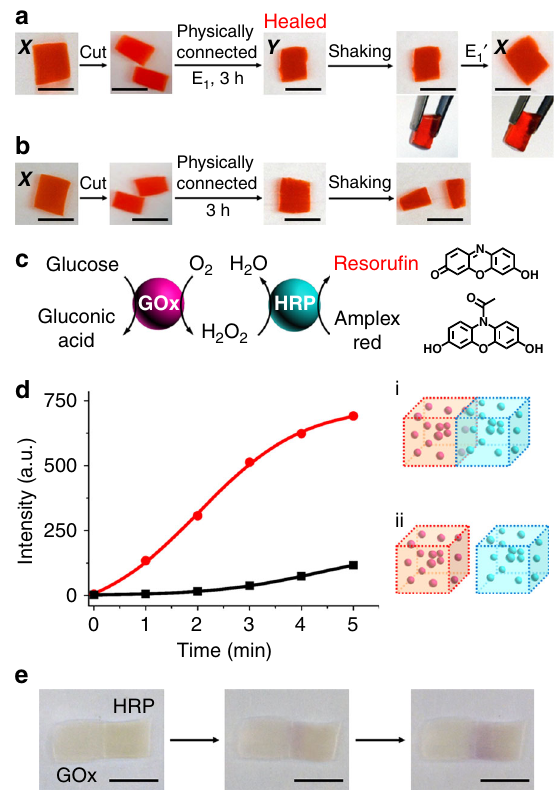
Fig. 4 Self-healing of the CDN hydrogel matrices for a biocatalytic cascade. a Self-healing of CDN hydrogel X. The hydrogel was cut into two pieces which were physically interconnected. The E 1 -induced transition of hydrogel X to the stiffer CDN hydrogel Y, yielded the healed hydrogel Y. Treatment of the healed hydrogel Y with E 1 ’ regenerated the healed hydrogel X. b A control experiment in the absence of trigger E 1 reveals that the E 1 -induced transition of hydrogel X to Y is mandatory to yield the healed hydrogel matrix. c Operation of a bi-enzyme cascade consisting of glucose oxidase (GOx) coupled to horseradish peroxidase (HRP). The aerobic oxidation of glucose yields gluconic acid and H 2 O 2 . The generated H 2 O 2 acts as a substrate for HRP that catalyzes the oxidation of Amplex Red to Resoru fi n. The latter product provides the fl uorescence readout signal for the biocatalytic cascade. d Time-dependent fl uorescence changes generated upon: (i) The operation of the GOx/HRP bi-enzyme cascade in a healed matrix composed of a GOx-loaded hydrogel matrix linked to a HRP-loaded hydrogel matrix; (ii) The operation of the bi-enzyme cascade in separated GOx-loaded hydrogel and HRP-loaded hydrogel matrices. e The color intensity changes of Resoru fi n generated by the bi-enzyme cascade reaction at the boundary of the healed hydrogel matrix. Scale bars in all images correspond to 0.5